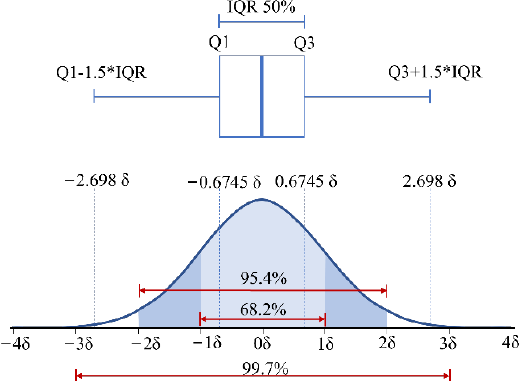
Figure 5. Interquartile range and empirical rule of a normal distribution.